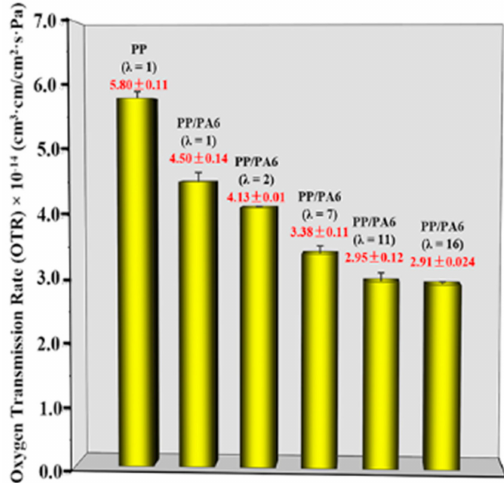
Figure 9. The oxygen transmission rates of the pure PP and the PP / PA6 blends with di ff erent stretch